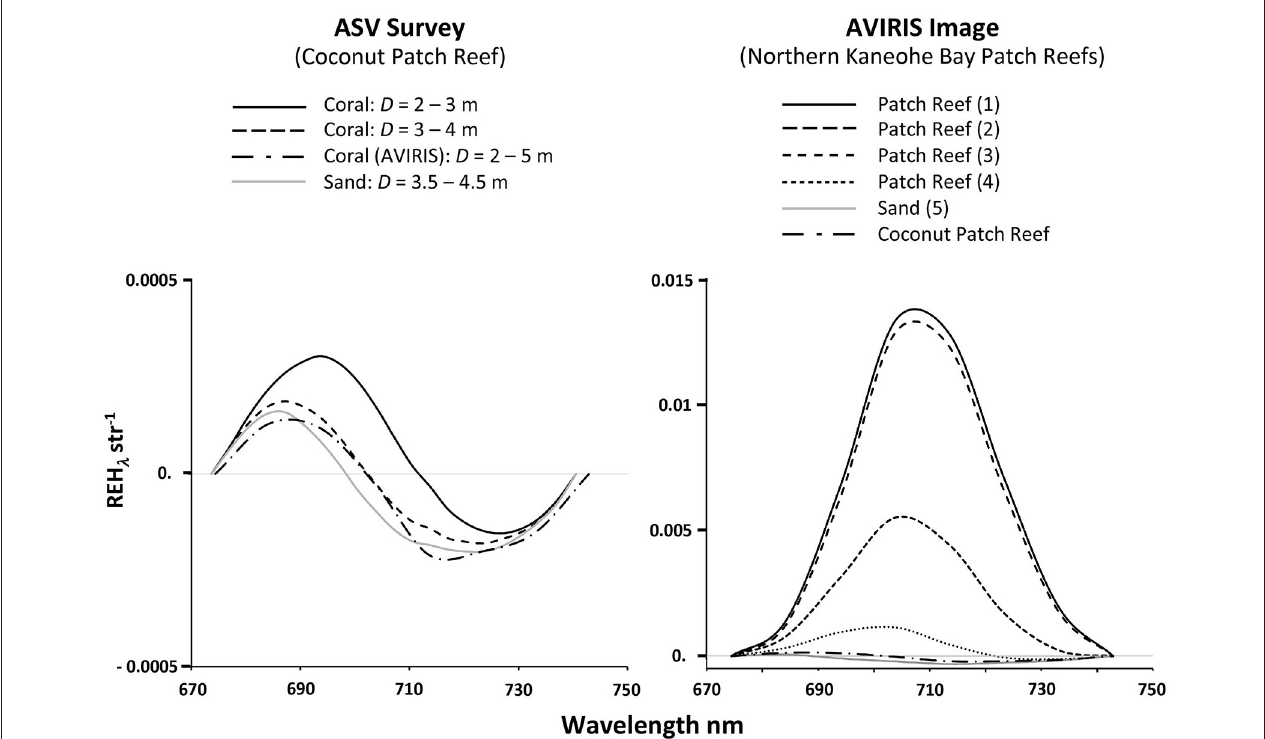
FIGURE 13 | Red edge height computed for data collected during the in situ survey of the coconut patch reef on 12 February 201 ( left ) and selected patch reefs in the northern Kane’ohe Bay imaged by AVIRIS on 3 March 2017 ( right ; locations indicated in Figure 4B ). For comparison, the AVIRIS REH λ signal is also plotted with the ASV data (dash-dot curve in both